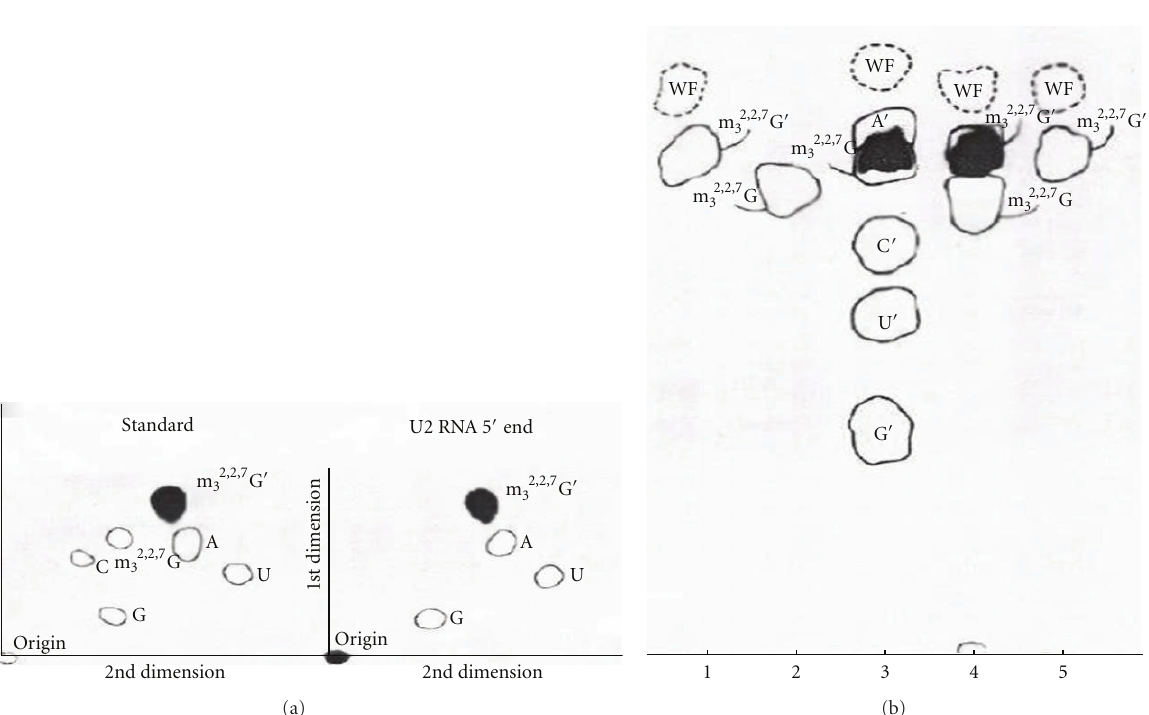
Figure 26: Fluorograph of [ 3 H]-labeled trialcohol derivatives of m 32,2,7 G from U2 RNA 5 (cid:2) end [12]. (a) Two-dimensional thin layer chromatography. (b) One-dimensional paper chromatography. In both systems, the labeled compound was m 32,2,7 G (cid:2) . (See